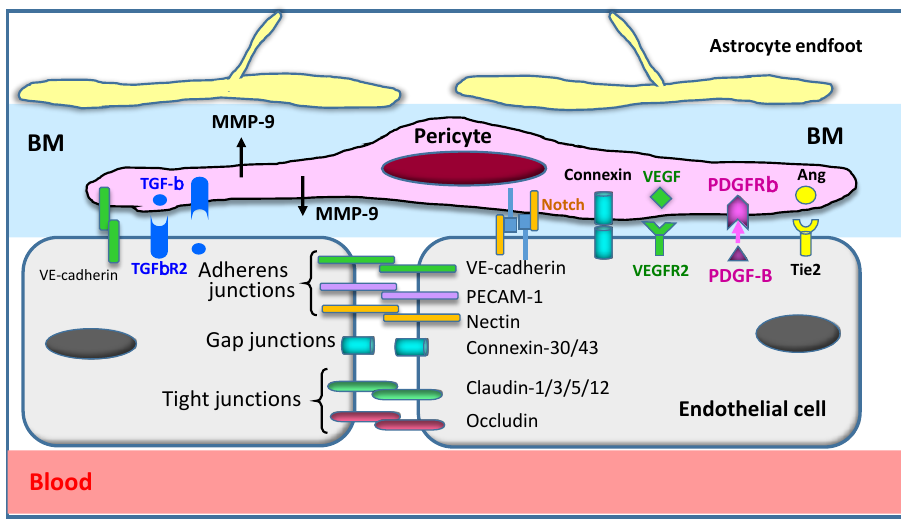
Figure 1. Structure of the blood–brain barrier (BBB). The BBB consists of vascular endothelial cells, pericytes, a basement membrane (BM), and astrocyte endfeet. Cellular components are integrated with many adhesive molecules and are functionally regulated by ligand–receptor systems. The major factors are drawn in this figure. Ang: angiopoietin; BM: basement membrane; MMP-9: matrix metallo proteinase-9; PECAM-1: platelet endothelial cell adhesion molecule-1; PDGF-B: platelet-derived growth factor-B; PDGFRb: platelet-derived growth factor receptor beta; TGF-b: transforming growth factor-b; TGFbR2: Transforming growth factor-b receptor 2; VE-cadherin: vascular endothelial cadherin; VEGF: vascular endothelial growth factor; VEGFR2: vascular endothelial growth factor receptor 2.